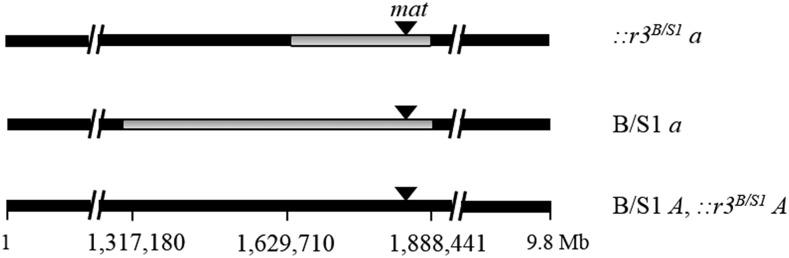
B/S1 crosses are heterozygous in mat-linked region. Chromosome 1 is 9.8 Mb long and its nucleotides are numbered as per the OR genome sequence (ID- CM002236). In the B/S1 a and ::r3B/S1 a strains the mat a locus and flanking sequences are derived from the Bichpuri-1 a strain and shown in gray, whereas in the B/S1 A and ::r3B/S1 A strains the corresponding sequences, shown in black, are derived from Spurger-3 A. In B/S1 a and ::r3B/S1 a sequences distal (leftward) to, respectively, nucleotides corresponding to positions 1317180 and 1629710 in the OR genome sequence, and proximal (rightward) to the nucleotide corresponding to position 1888441, are identical to those in the B/S1 A sequence. Thus, the crosses ::r3B/S1 a x B/S1 A and ::r3B/S1 a x ::r3B/S1 A are heterozygous for a ∼258,731 bp mat-linked segment, whereas the crosses B/S1 a x B/S1 A and B/S1 a x ::r3B/S1A are heterozygous for a ∼570,329 bp mat-linked segment. Overall, the ::r3B/S1a x B/S1 A and B/S1 a x ::r3B/S1A crosses are heterozygous for, respectively, ∼303 kbp (0.7%) and ∼614 kbp (1.4%) of the genome (see text). Sequence accession numbers are MG009253 and MG017489 (Spurger), MG009254, MG017490 and MK392333 (B/S1 A); MK392332 (B/S1 a); MG009255 and MG017491 (::r3B/S1a), and MG009256 and MG017492 (Bichpuri).